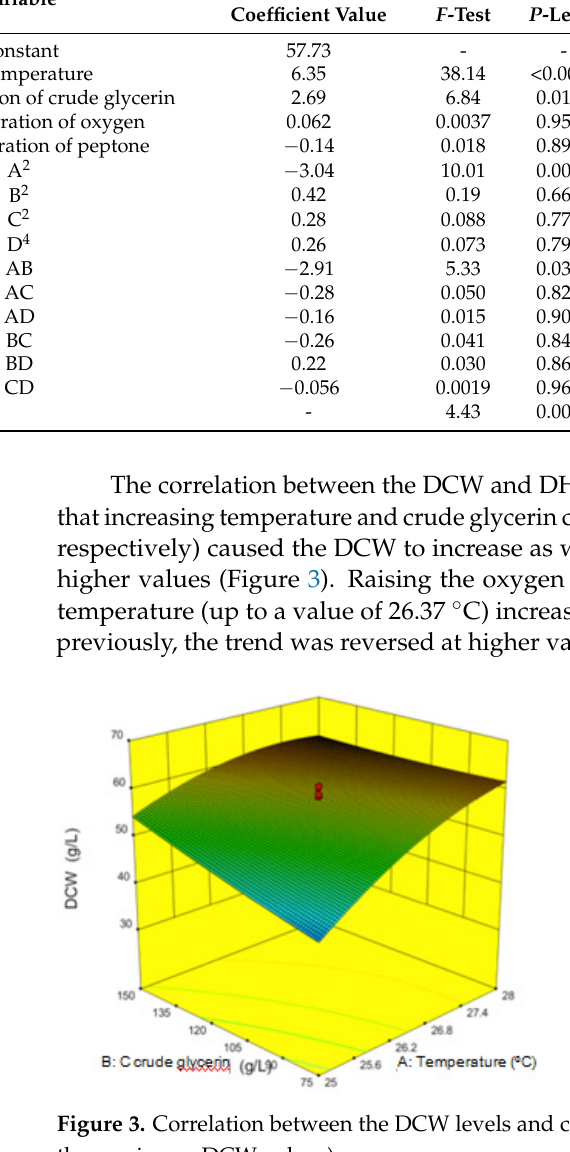
Table 9. Second-order polynomial equation coefficient values, with related F-test and P-test results.